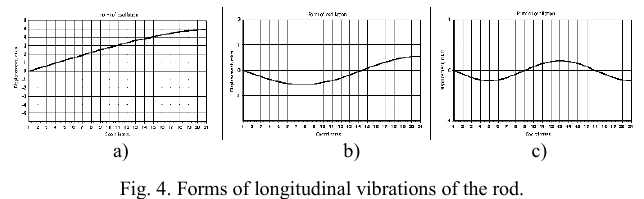
Fig. 4. Forms of longitudinal vibrations of the rod.